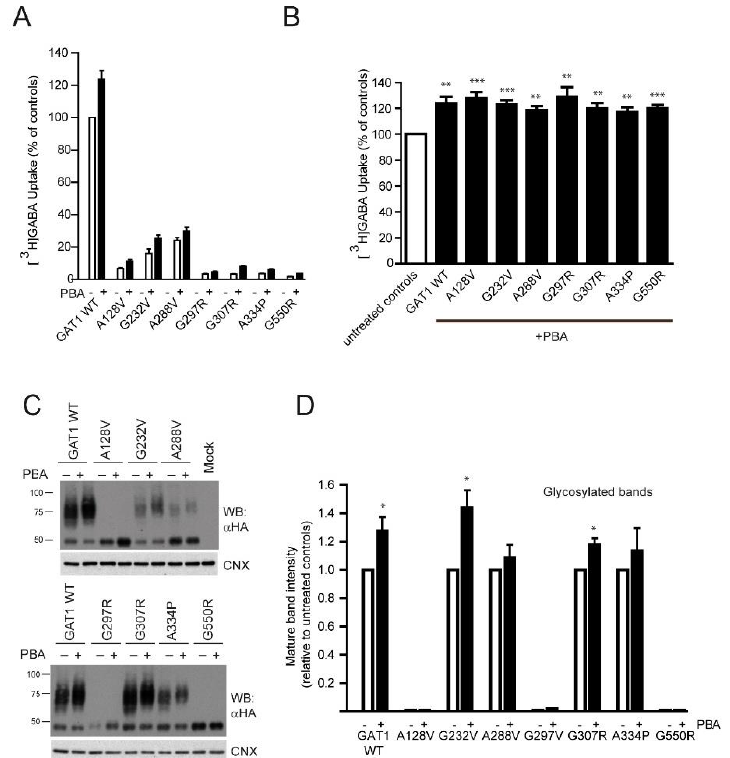
Figure 11. Effect of 4-phenylbutyrate on the activity and expression levels of GAT-1. ( A ). HEK293 cells were transfected with 0.5 µg of the expression vectors for the indicated variants of GAT-1, and 24 h later were treated with 2 mM PBA for 24 additional hours. Then, cells were incubated for 10 min in the presence of 0.1 µCi of [ 3 H]GABA and the incorporated radioactivity was determined in a scintillation counter. Values represent the percentage of the activity observed in the controls (GAT-1 WT) after correction for the background observed in mock-transfected cells and represent the mean ± SEM of three triplicate experiments. **: p < 0.005; ***: p < 0.001, paired t -test. ( B ). HEK293 cells were transfected with 0.25 µg of the expression vectors for the indicated variants of HA-GAT-1 plus 0.25 µg of HA-GAT-1 WT. Uptake assays were performed and processed as indicated in ( A ). ( C ). Samples of transfected cells were analyzed by western blot using anti-HA antibody and reprobed with anti-calnexin. ( D ). The intensity of the mature glycosylated band was measured by densitometry. Values represent the mean ± SEM of four experiments after normalization to the ratio obtained for the untreated controls. *: p < 0.01, paired t -test.